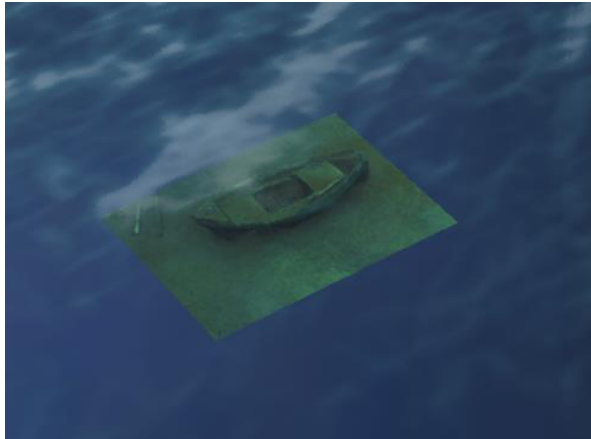
Figure 13. The model of the shipwreck in Google Earth. © Google Earth (2016)